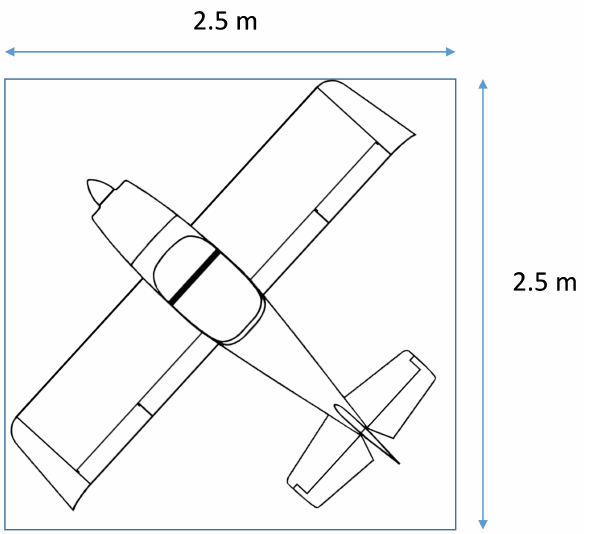
Figure 6: Maximum dimensions allowed for the aircraft.